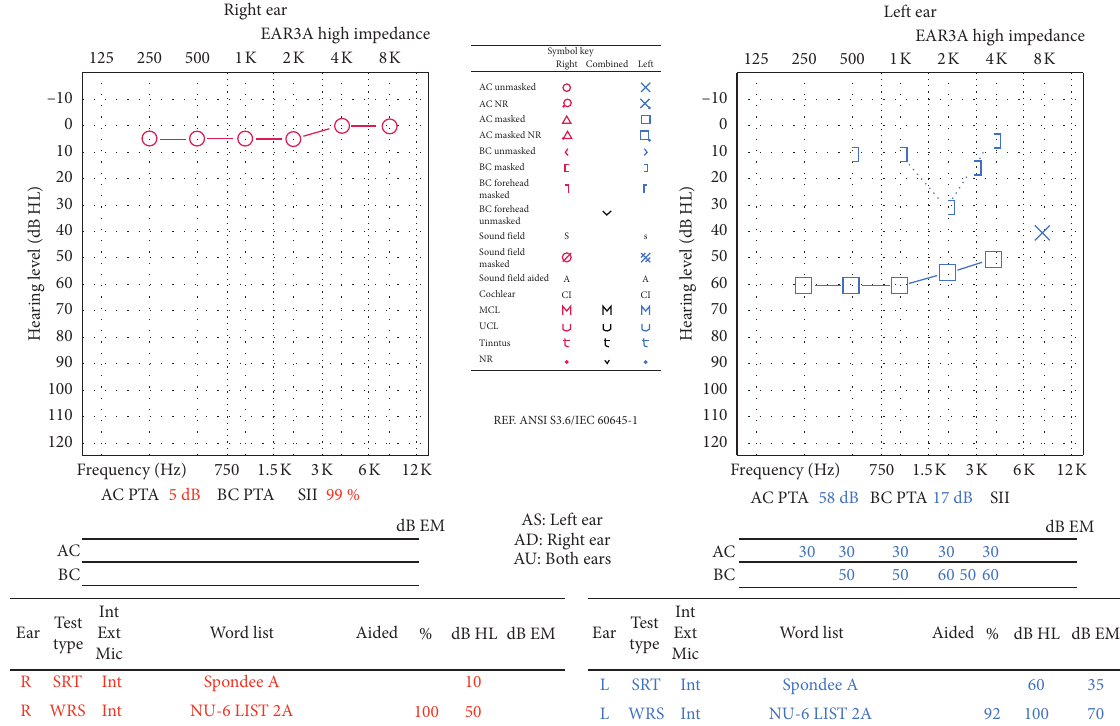
Figure 1: Audiogram showing normal hearing on the right and a moderate-severe rising to moderate mixed hearing loss with 25–50dB air- bone gap on the left. Word recognition scores were excellent bilaterally.